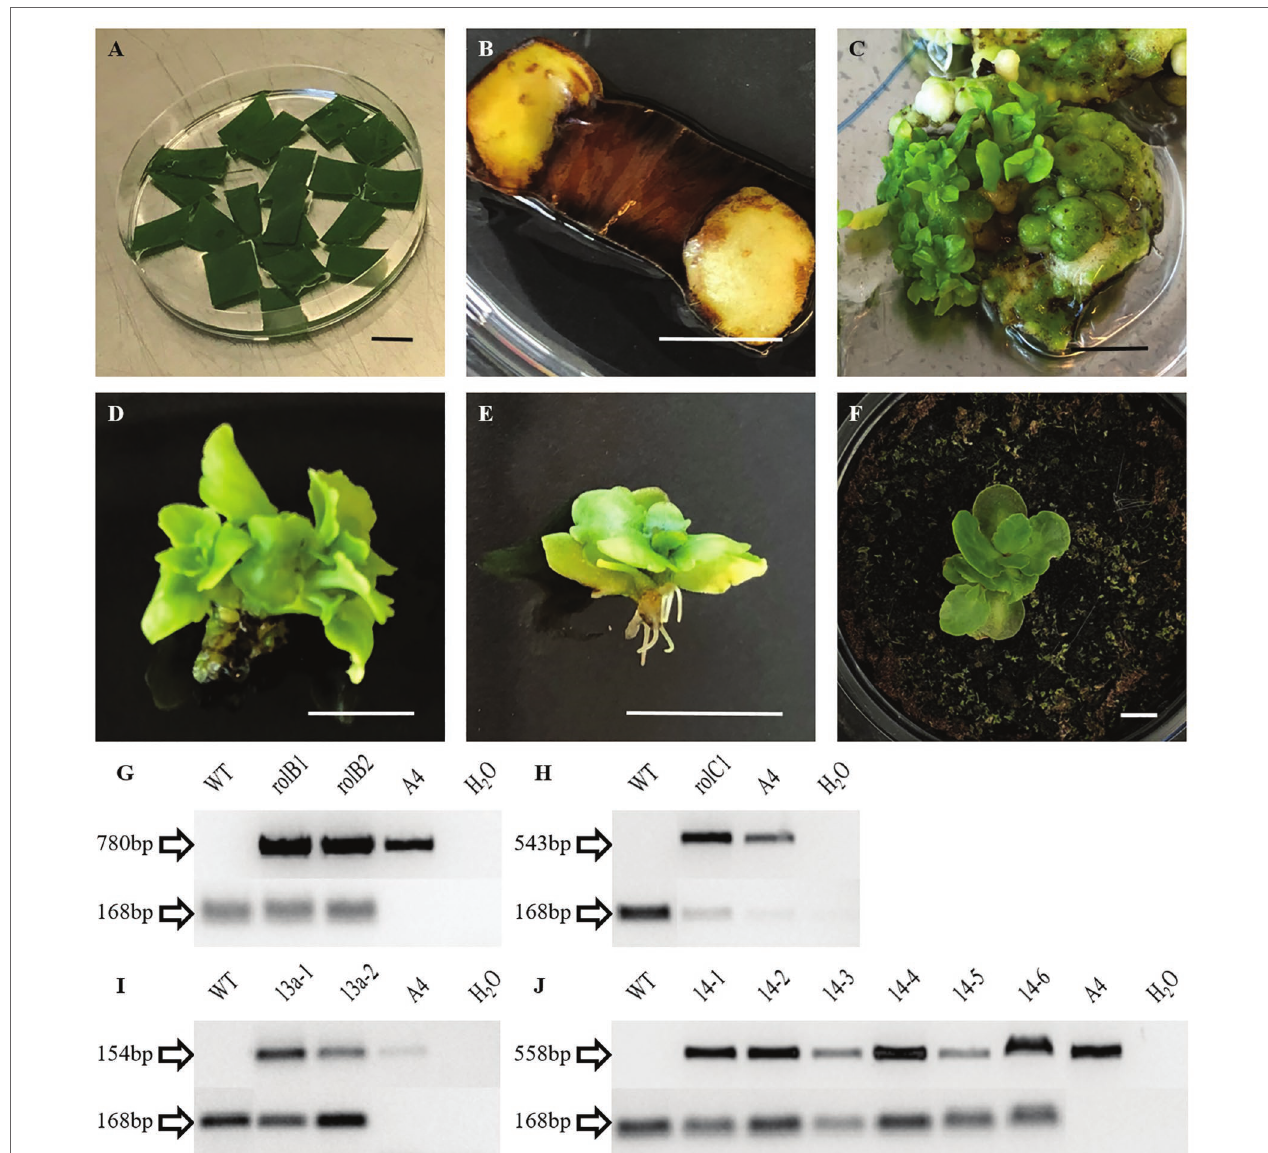
FIGURE 1 | Transformation, regeneration, and molecular characterization for Kalanchoë blossfeldiana ‘Molly’. K. blossfeldiana ‘Molly’ (A) surface sterilized explants ready for inoculation (B) senescence associated with kanamycin selection. (C) Callus and initial shoots in K. blossfeldiana ‘Molly’ explants (D) excised shoot, and (E) at a later stage bearing roots. (F) Kalanchoë blossfeldiana ‘Molly’ rooted shoots transferred to peat. Genotyping by PCR of regenerated and selected K. blossfeldiana ‘Molly’ lines using full-length primers targeting (G) rol B (780 bp), (H) rol C (543 bp), (I) Δ ORF13a (154 bp), and (J) ORF14 (558 bp). Kalanchoë daigremontiana Actin ( KdActin ) was the plant reference gene with amplicon of 168 bp, A4 is the unmodified plasmid from Rhizobium rhizogenes and positive control for the rol genes/open reading frames (ORFs) PCR reactions, and H 2 O was the negative control for both plant and rol genes/ORFs PCR reactions (see Supplementary Table S1 for the detailed list of primers). WT, wild type. Bar = 1 cm.